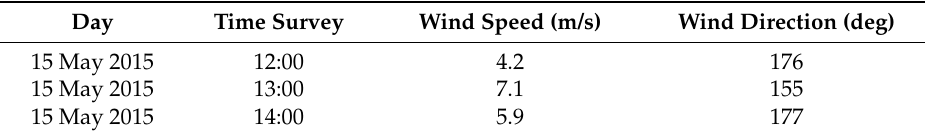
Table 2. Wind parameters during the measurements campaign.